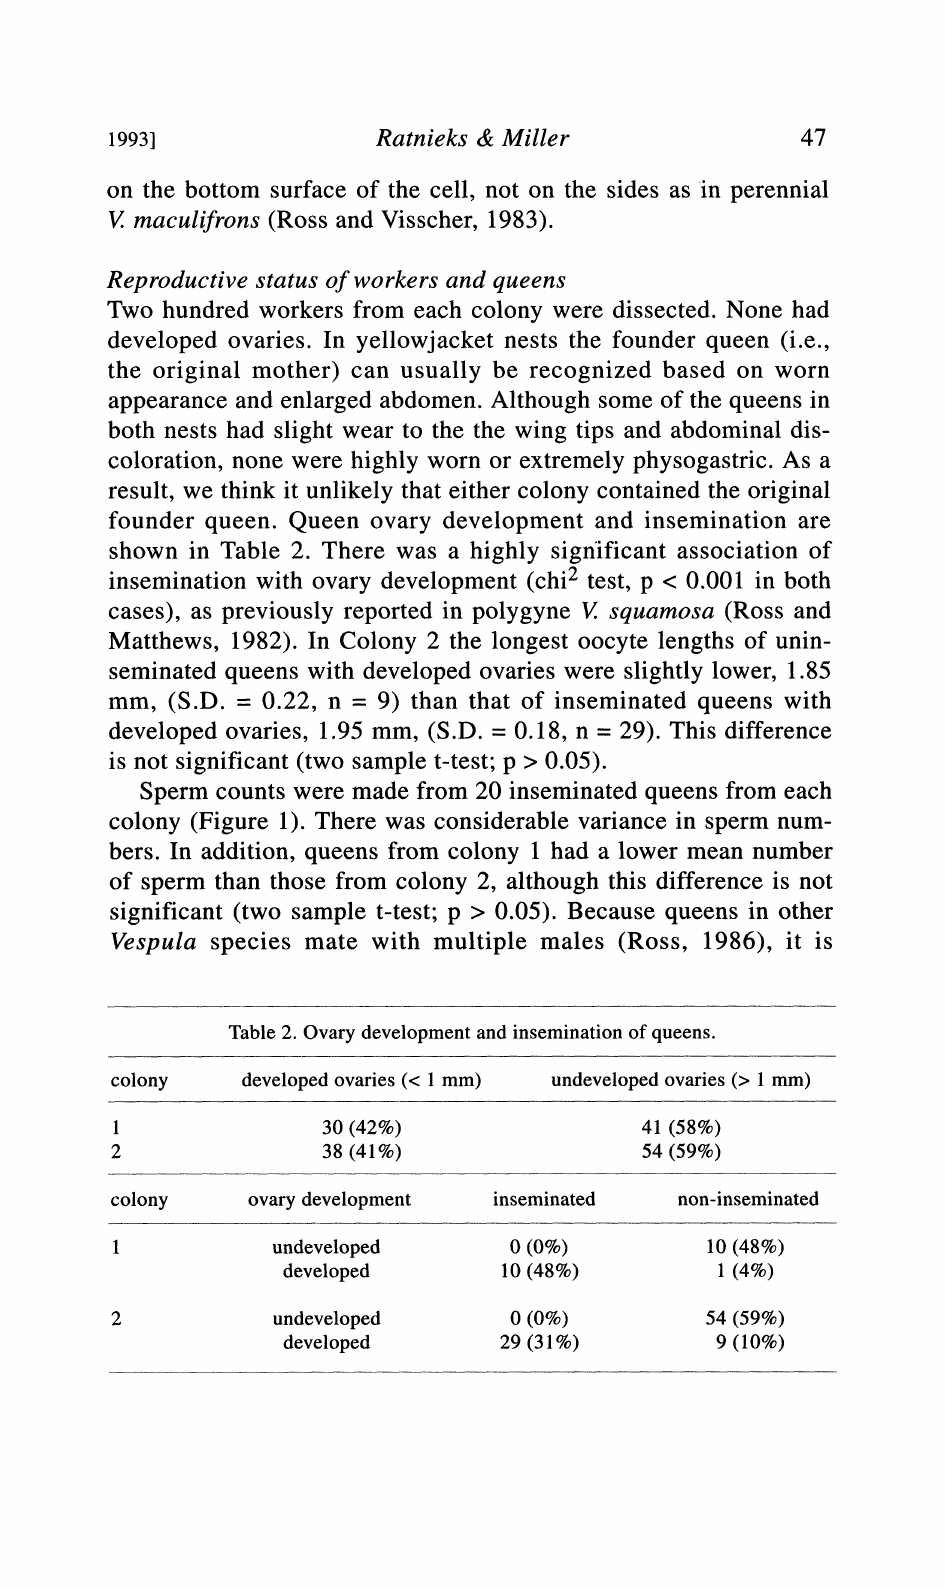
Table 2. Ovary development and insemination of queens.